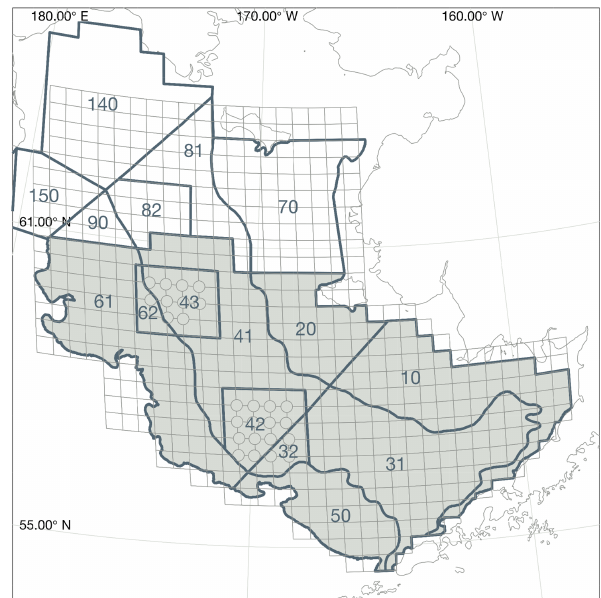
Figure 2. Bering Sea groundfish survey stratified sampling poly- gons. The area considered for calculation of the cold pool index in the model is shaded. The grid cells for each trawl, including bottom temperature measurement samples, are indicated by the light gray lines (circles on the corner of grid cells indicate crab resampling locations; data points from these locations were used in the spatial interpolations shown in Fig. 4 but were removed from cold pool index calculations to avoid unequal